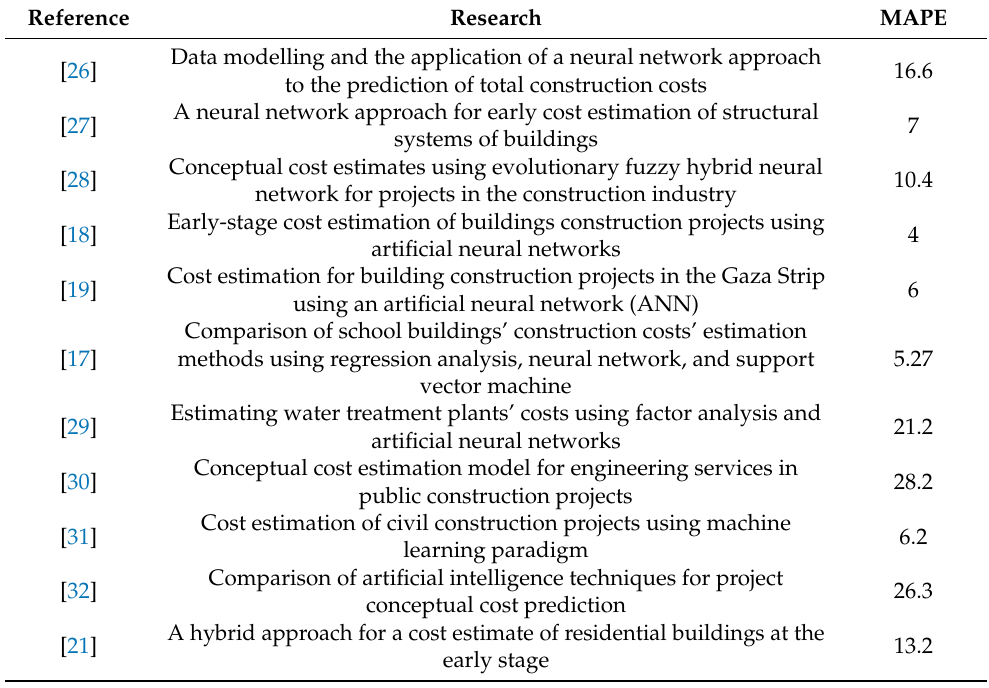
Table 2. The minimum absolute percentage errors for the previous